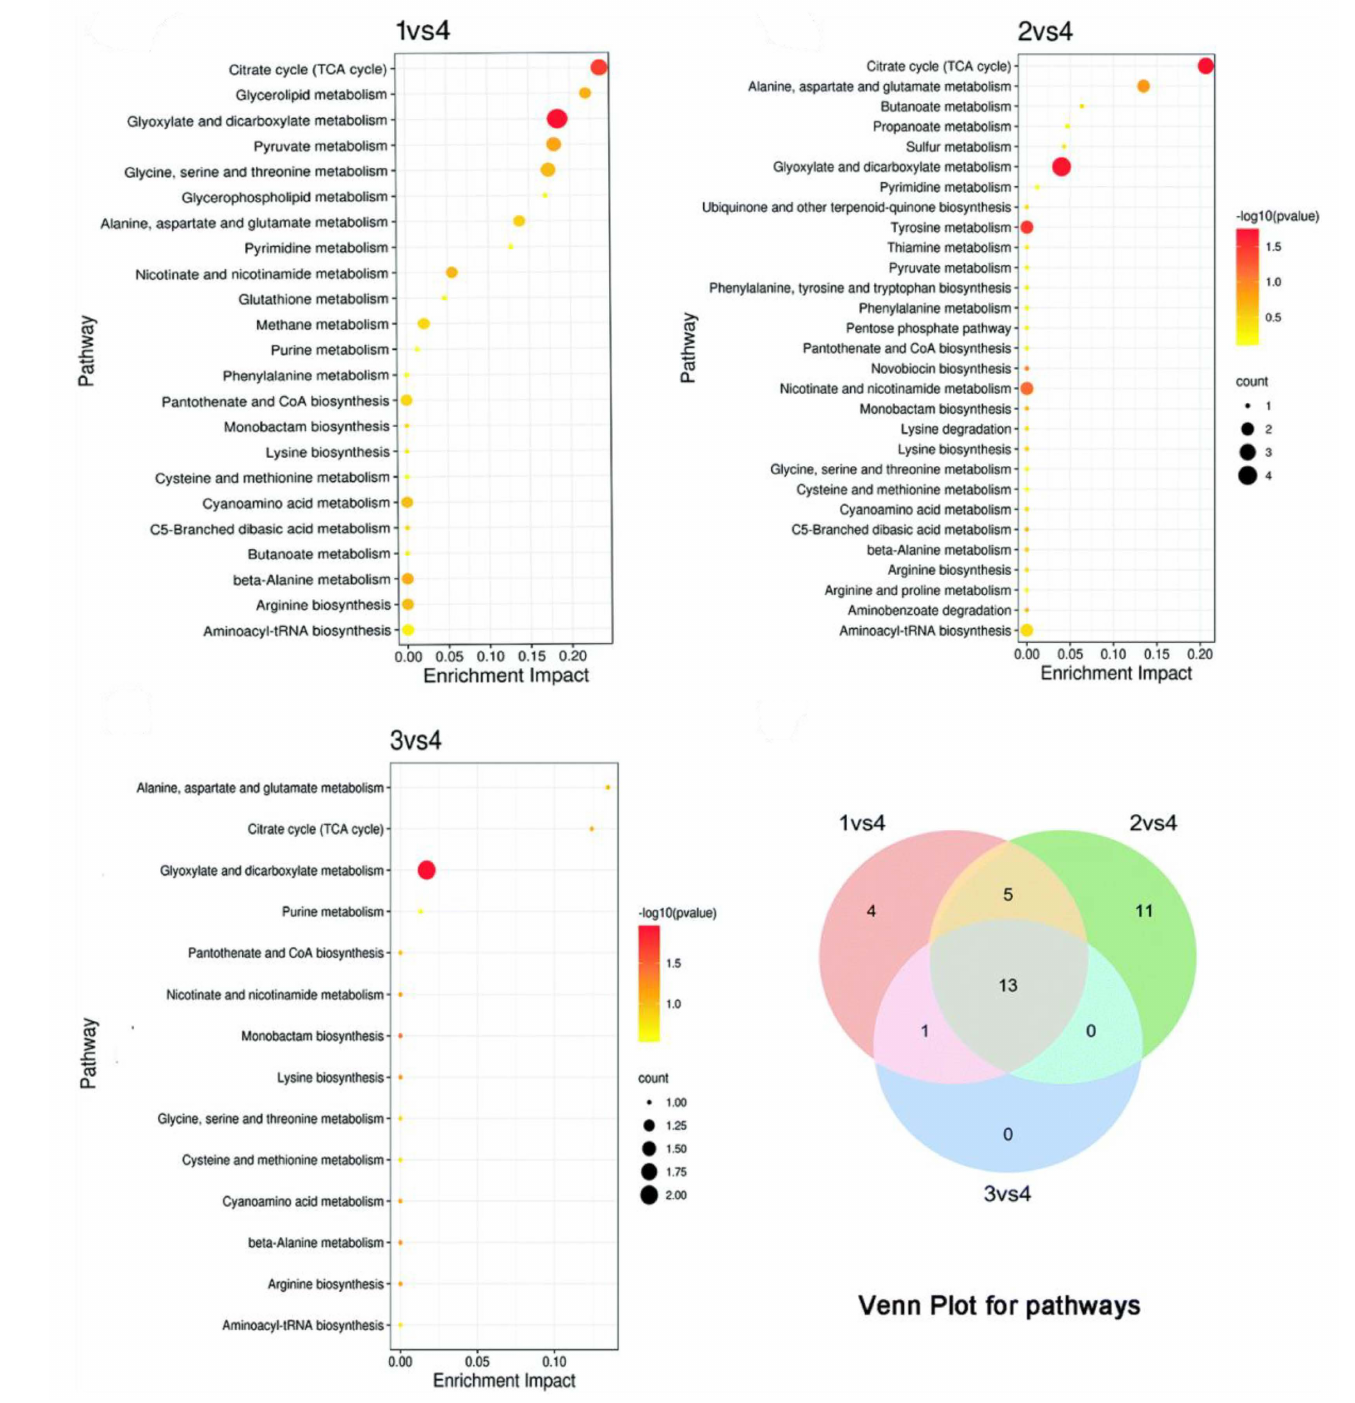
Figure 9. The pathway enrichment and Venn plot of pathways of three group pairs (1: NOR + Ag NFs, 2: Ag NFs, 3: NOR; 4: